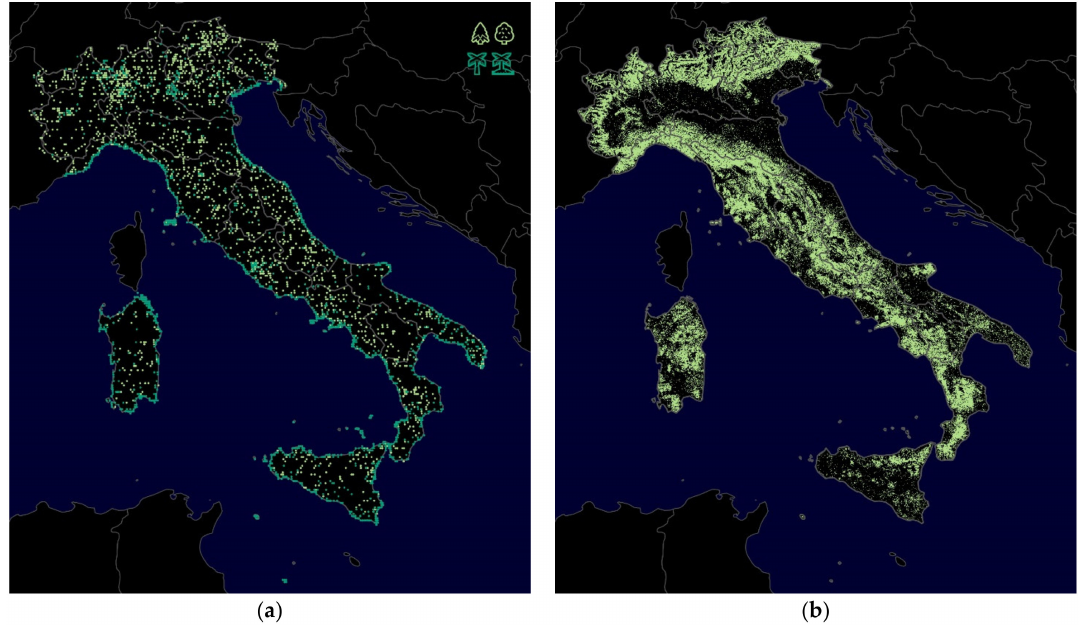
Figure 11. (a) Spatial distribution of location-specific emojis in Italy representing the predominant tree vegetation; (b) forest area in Italy [50].